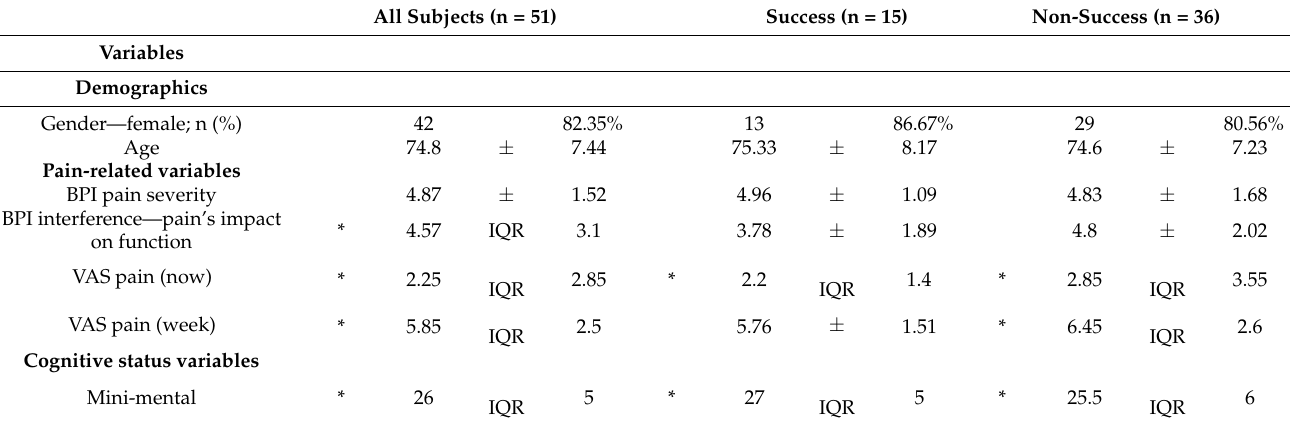
Table 1. Variables assessed at